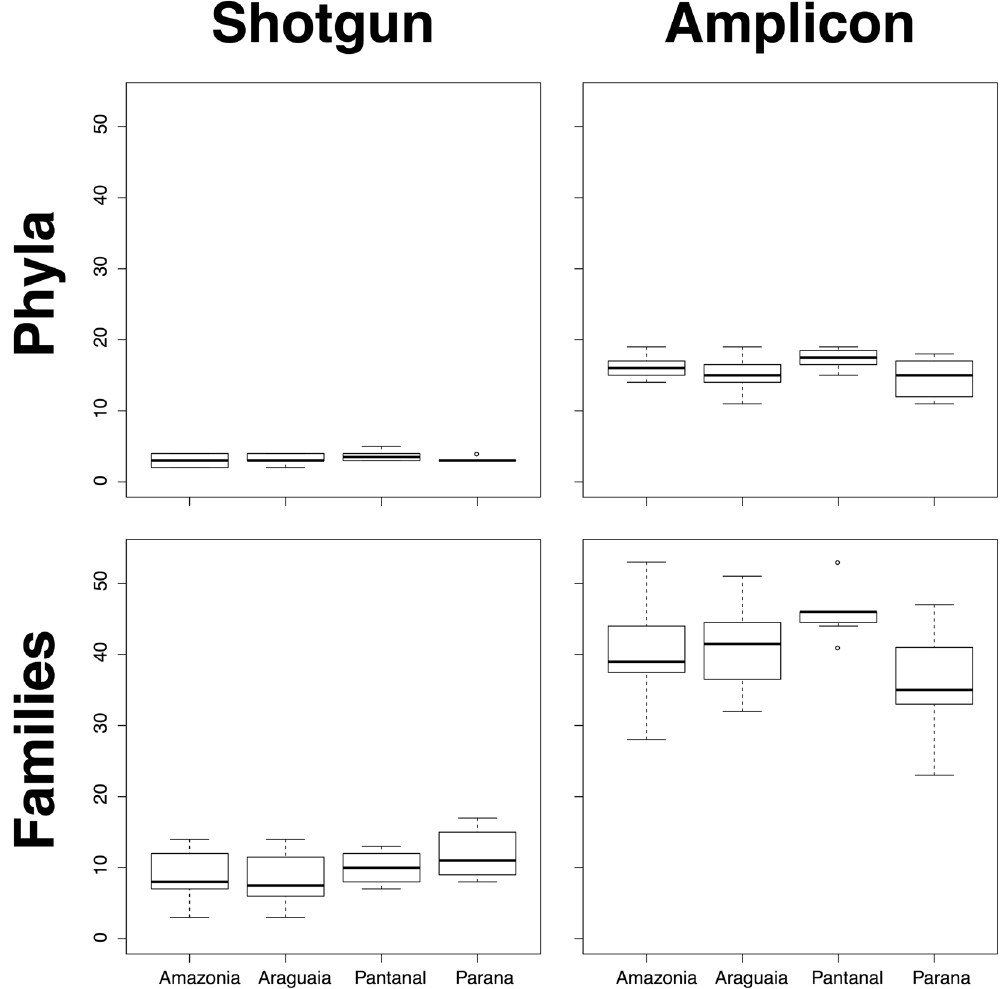
Figure 3. Box-and-whisker plots of shotgun vs. amplicon sequencing strategies showing taxon richness at the phylum and family levels. Boxes are middle quartiles divided by the medians, whiskers are 1.5x the interquartile range, and dots are